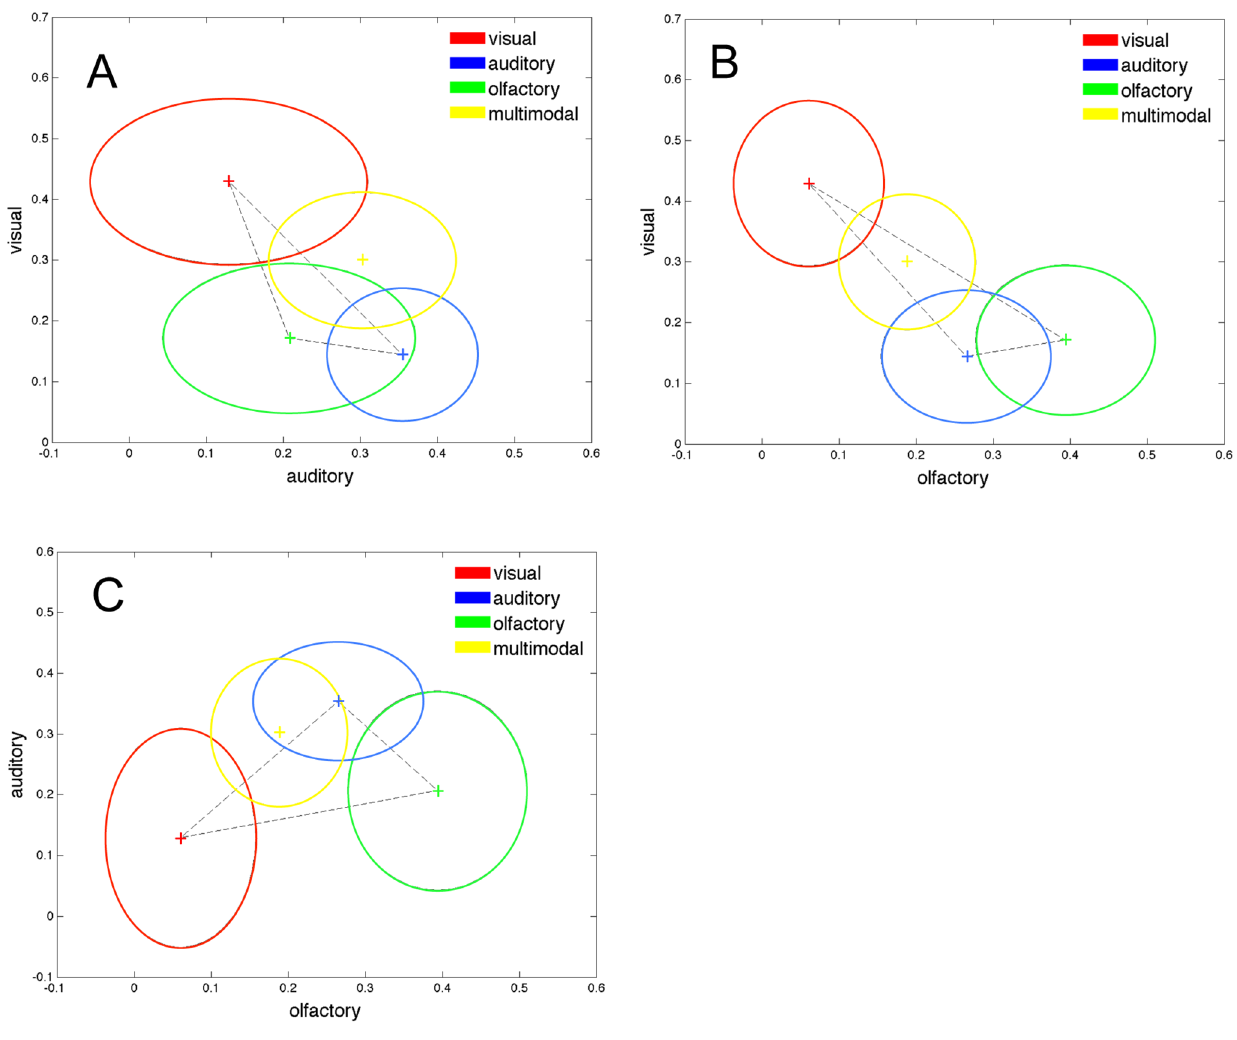
Figure 2. Mean and standard deviations of each condition plotted for the pairwise unimodal combinations of the four semantic scales. The axis represents the semantics scales (multimodal, visual, auditory, or olfactory). Panel A–C represent all possible pairwise combinations these scales, e.g., panel A have the auditory scale on the x-axes and the visual semantic scale on the y-axis. Crosses represent mean values for each condition (red crosses the visual-, blue crosses the auditory-, green crosses the olfactory-, and yellow crosses the multimodal condition respectively) and the circles represents a 95% confidence interval.